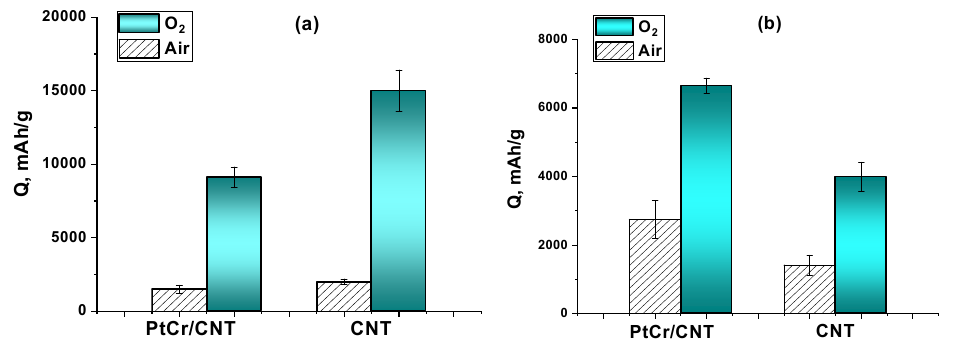
Figure 2. The discharge capacity of LOB based on PtCr/CNT and CNT measured at 200 mA/g ( a ) and 500 mA/g ( b ) in atmospheres of pure oxygen and air. The capacity values are presented with mean square deviation (according to the data of three experiments). 1 М LiClO 4 /TEGDME.